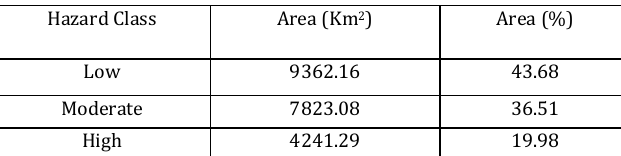
Table 5: Area Statistics of Flood Hazard Zonation in the study area